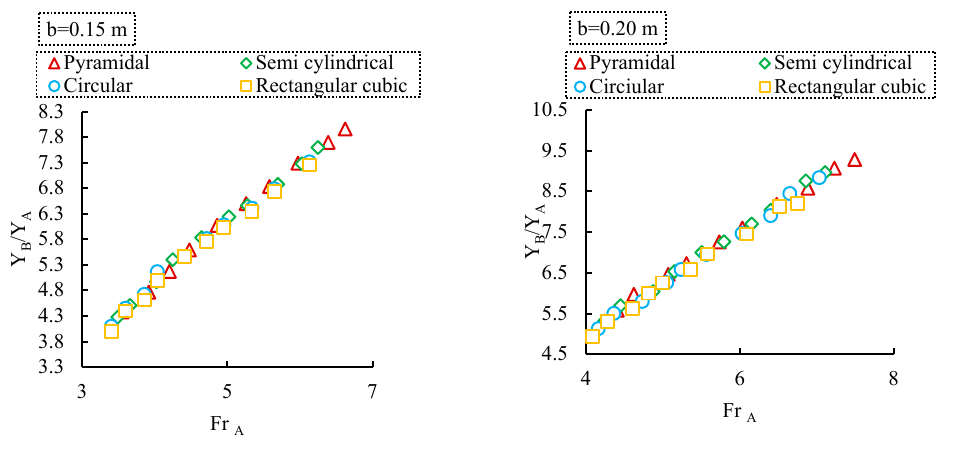
Figure 11. Effect of sill geometry on hydraulic depths.